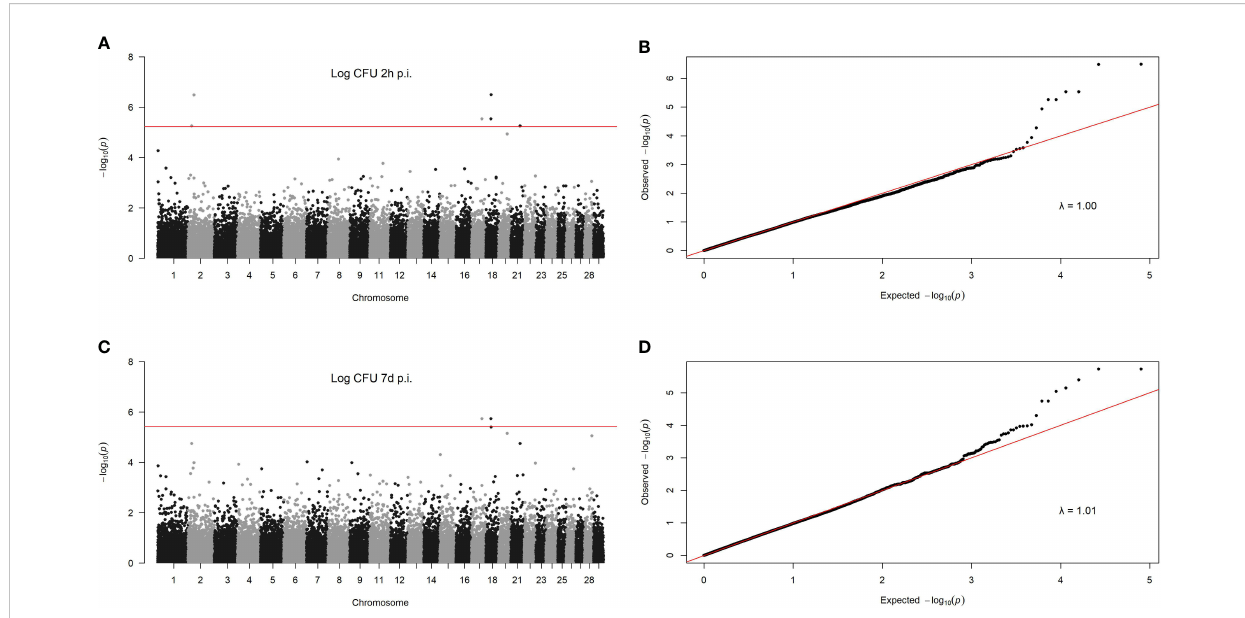
FIGURE 3 GWAS for MAP load within infected MDMs. Manhattan plots showing – log10 (P-values) of association between every single SNP and intracelllar MAP load within MDMs at 2 h (A) and 7 d p. i. (B) and 7 d p. i. (C) . Each dot represents the result from the test association for a single SNP. The chromosomes´ locationof the SNPs is indicated on the x-axis. The horizontal red line represents the genome-wide signi fi cance threshold – log 10 (P FDR ). Quantile-quantileplots comparing the observed distribution of – log (P-values) for the intracellular MAP load within MDMs at 2 h (D) to the expected values under the null hypothesis.